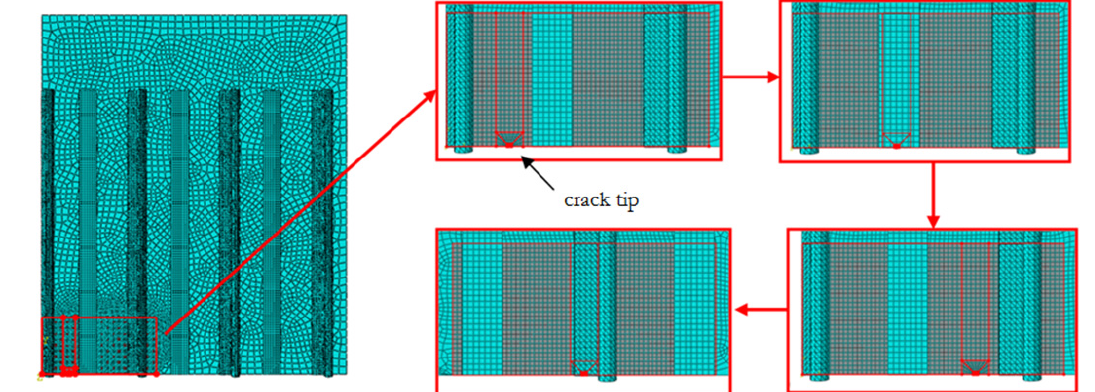
Figure 11: The mobile partition around the crack